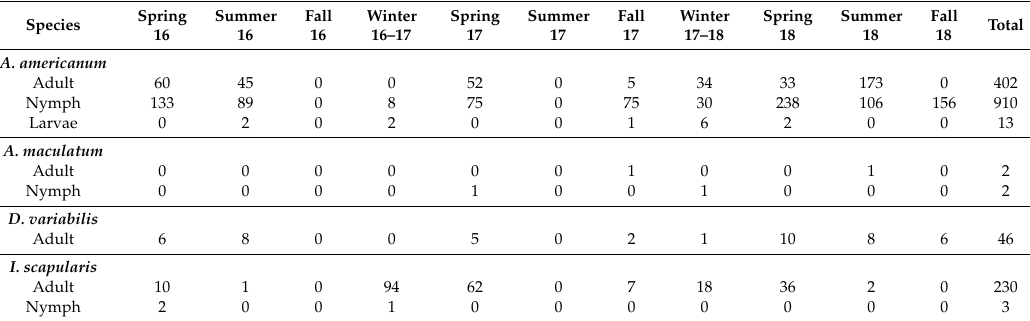
Table 3. Species identity and sample size of ticks screened across the entire state of Florida between spring 2016 and fall